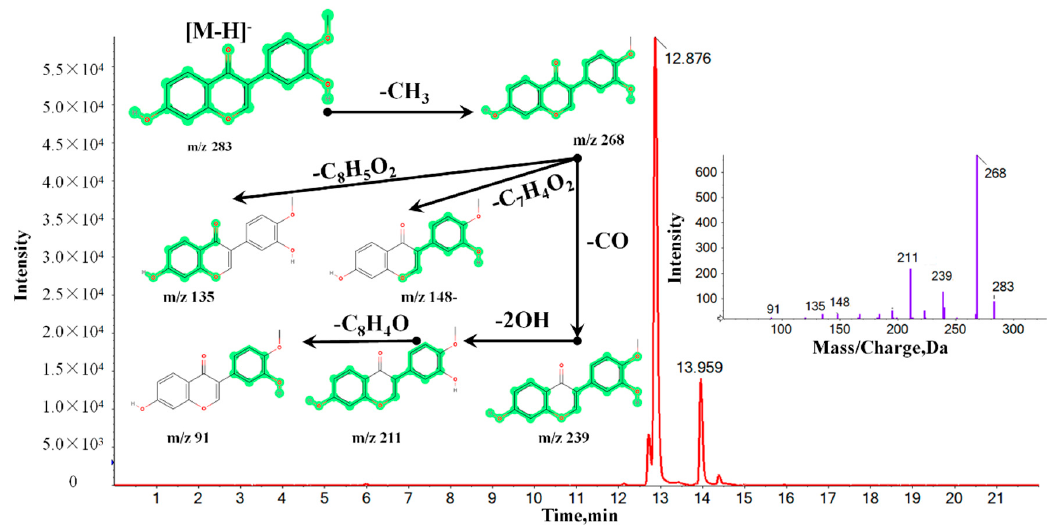
Figure 4. The MS and MS / MS information of Calycosin detected in the MG group by UHPLC-ESI-Q-TOF-MS / MS. Table 1. The detailed information of identified components in positive ion mode and negative ion mode byUHPLC-ESI-Q-TOF-MS /